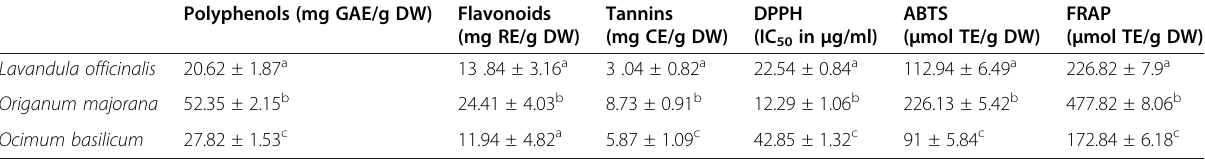
Table 1 Phenolic, flavonoid, and tannin content and in vitro antioxidant activities of three Lamiaceae species aqueous extracts